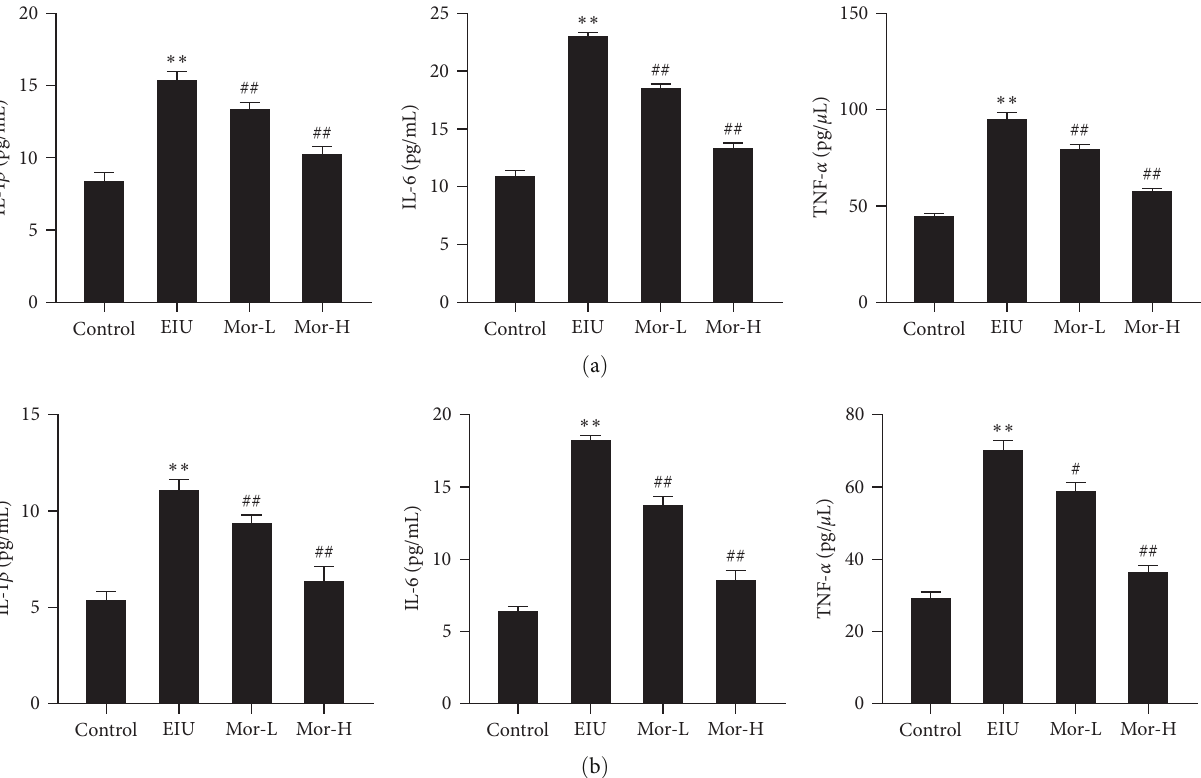
F IGURE 2: Effect of morroniside on the levels of in fl ammatory factors and in fl ammatory cell counts in EIU mice. (a) The levels of IL-1 β , IL-6, and TNF- α in the ciliary body. (b) The levels of IL-1 β , IL-6, and TNF- α in the retinal cells. Mean Æ SD from three independent samples are shown. Comparison with the control group: ∗∗ P < 0 : 01. Comparison with the EIU group: # P < 0 : 05, ## P < 0 : 01.